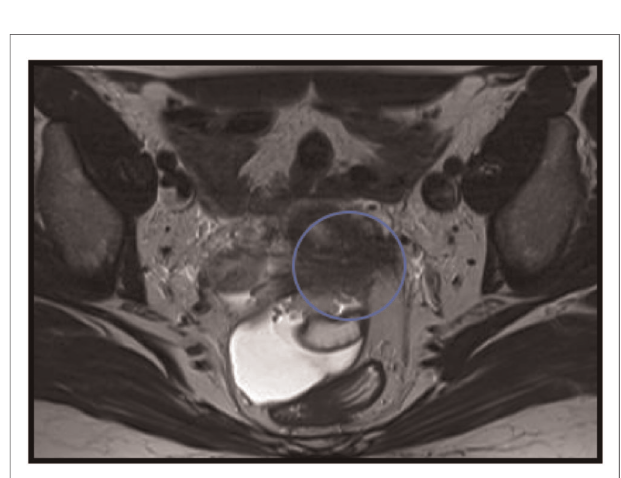
FIGURE 5 | Para-AX T2, utero-sacral ligament